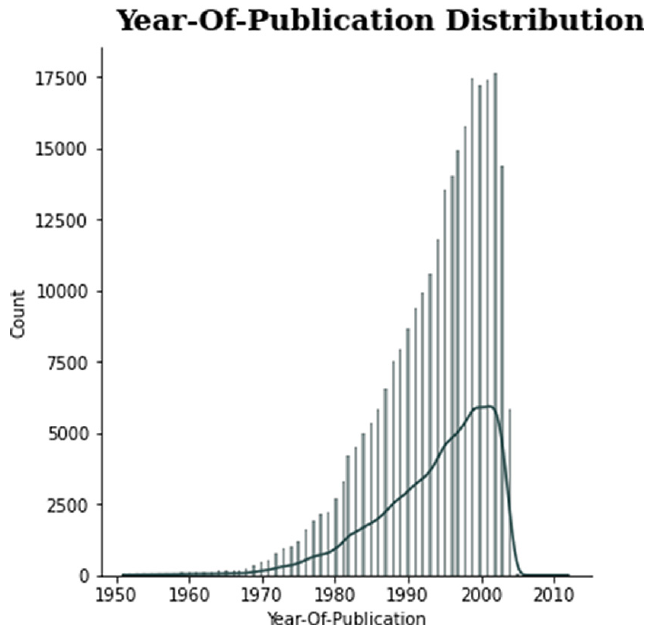
Fig. 5. Graph of distribution of book publications in